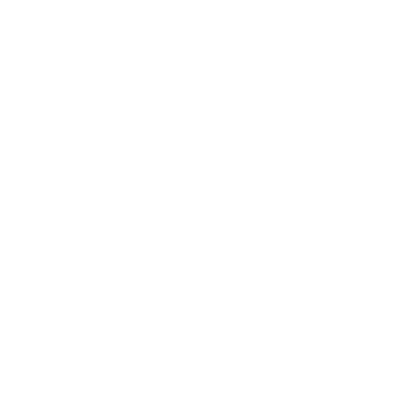
Figure 7. FT-IR spectrum of the nano-catalyst ( a ) and recovered Cu@Met-β ‐ CD ( b